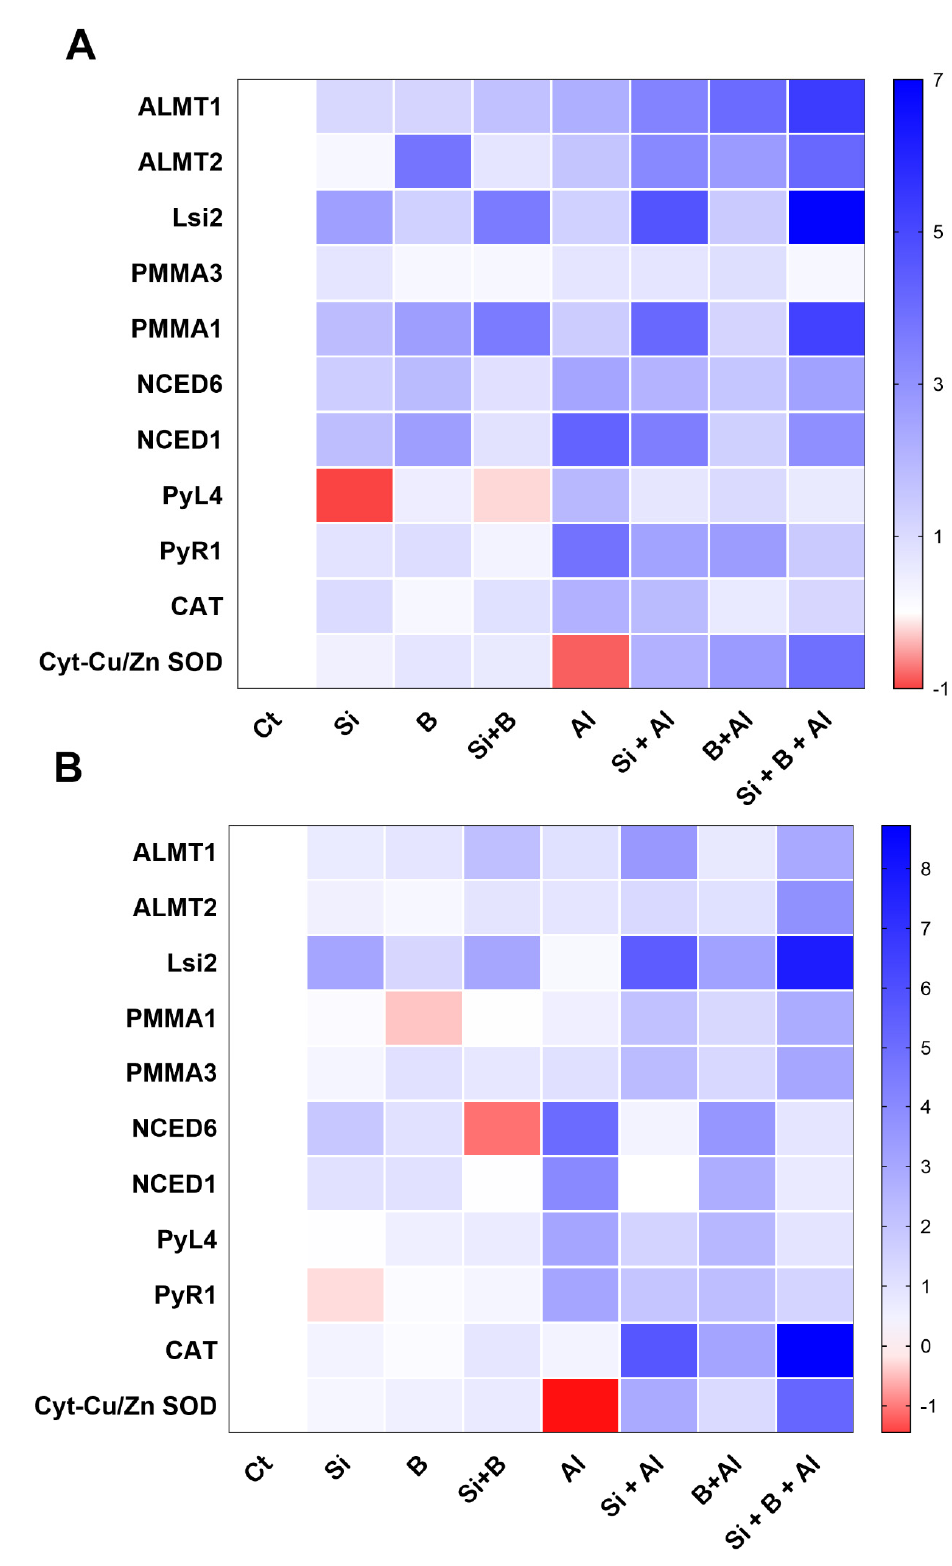
Figure 6. The sole and in combination effect of Si and B on the regulation of gene expressions in date palm ( A ) shoots and ( B ) roots under control and Al-induced stress conditions. The red color represents a lower relative transcript accumulation concerning control, and the blue color represents a higher transcript